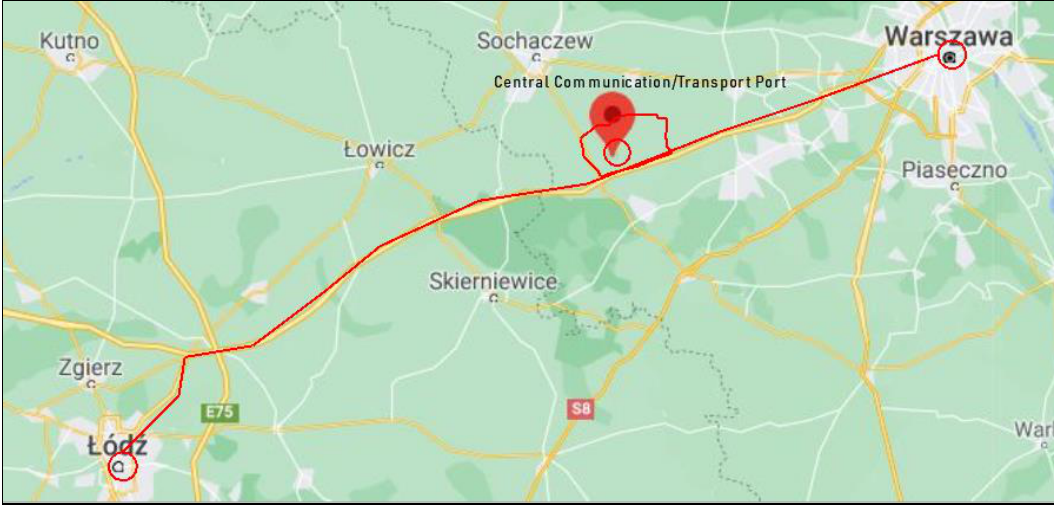
Figure 4. Potential Hyperloop route Łódź-STH-Warsaw.